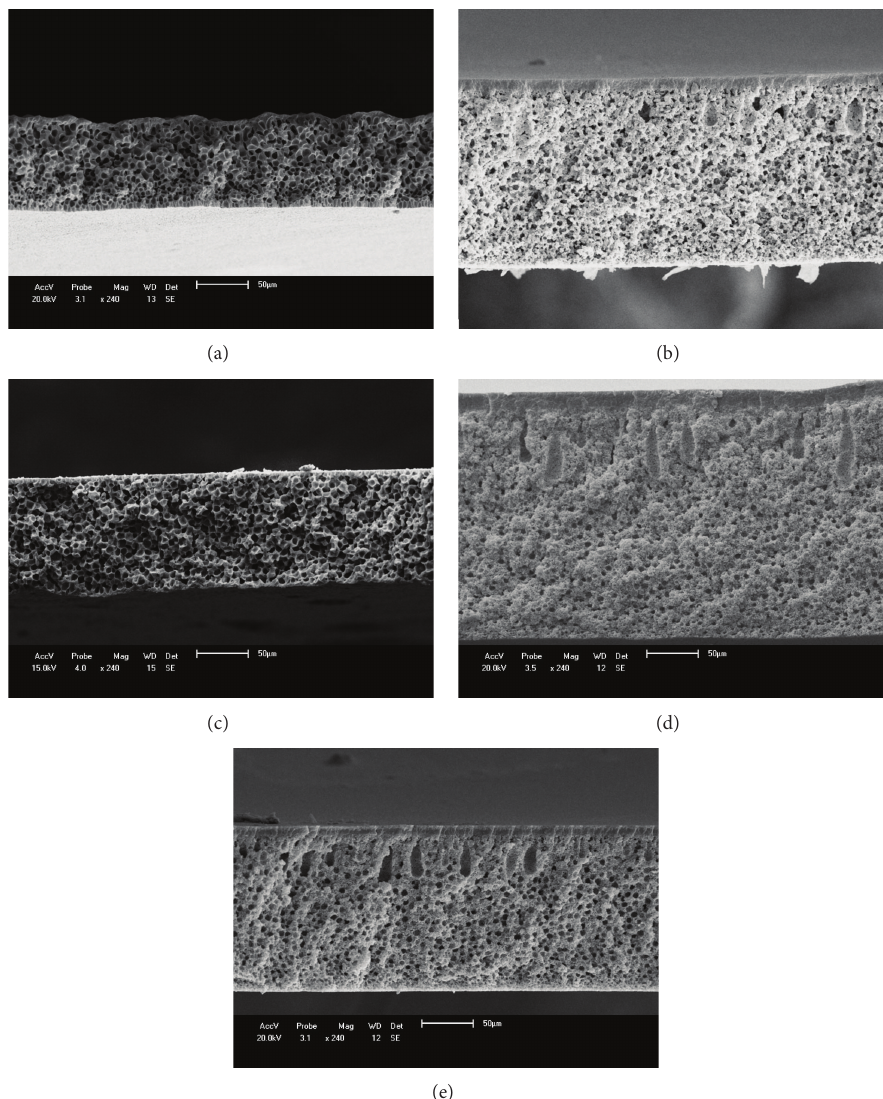
Figure 3: SEM images of the cross section of the membranes: (a) Pure PA6, (b) Homogenizer PA6, (c) Extruder PA6, (d) Homogenizer PA6+1%MMT, and (e) Extruder